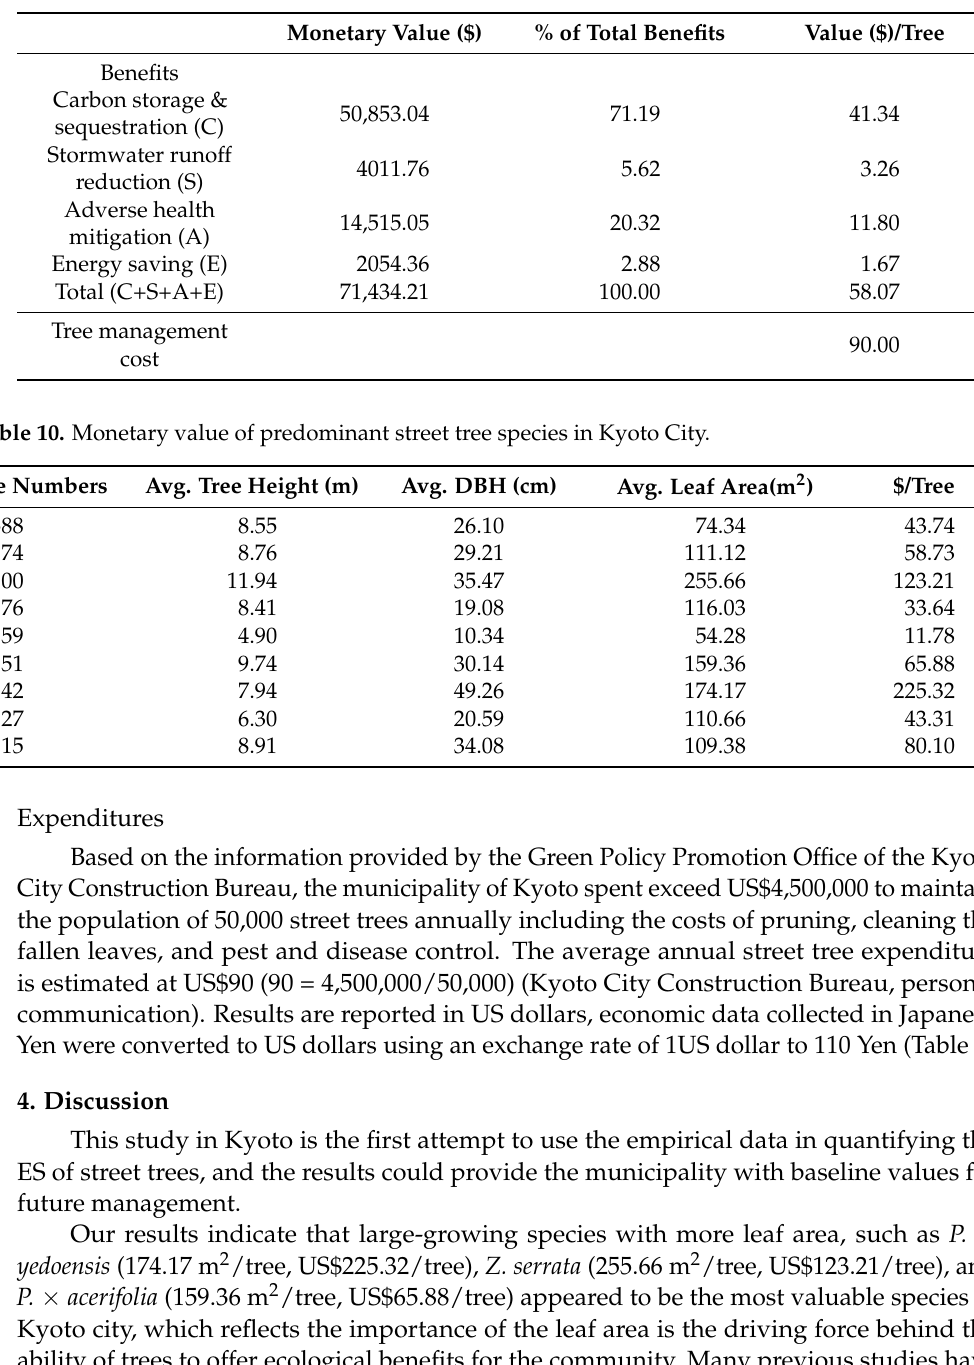
Table 9. Annual benefits-cost summary of sample street trees.